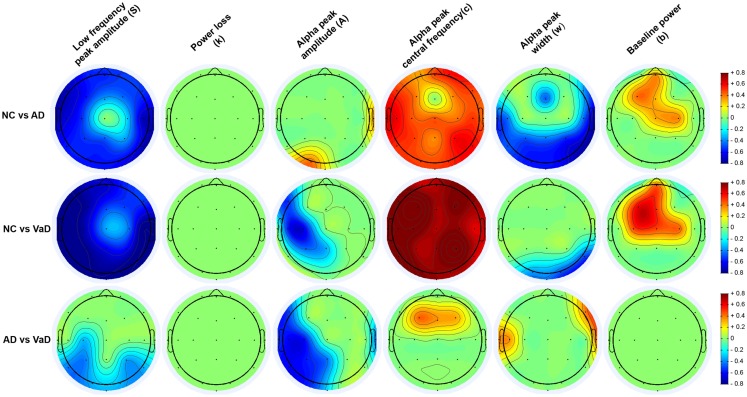
Topography of the parameters effect sizes (S, k, A, c, w, and b) between groups (NC, AD, and VaD). Red or blue color gradients denote, respectively, a positive or negative effect when comparing the groups using Cohen’s d effect size scale (|d| < 0.2 – small effect; 0.2 < |d| < 0.8 – medium effect; |d| > 0.8 – large effect).